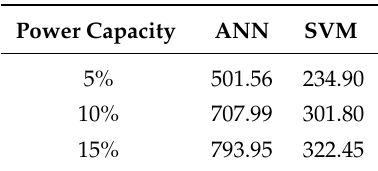
Figure 9. Operation of the ESS for the SVM scheme with varying time intervals of day time (Tolerance limit = 5%). Table 3. The average amount of the hourly exchanged power [kW] of ESS both the ANN and SVM schemes for a 30-MW PV system (Tolerance limit =